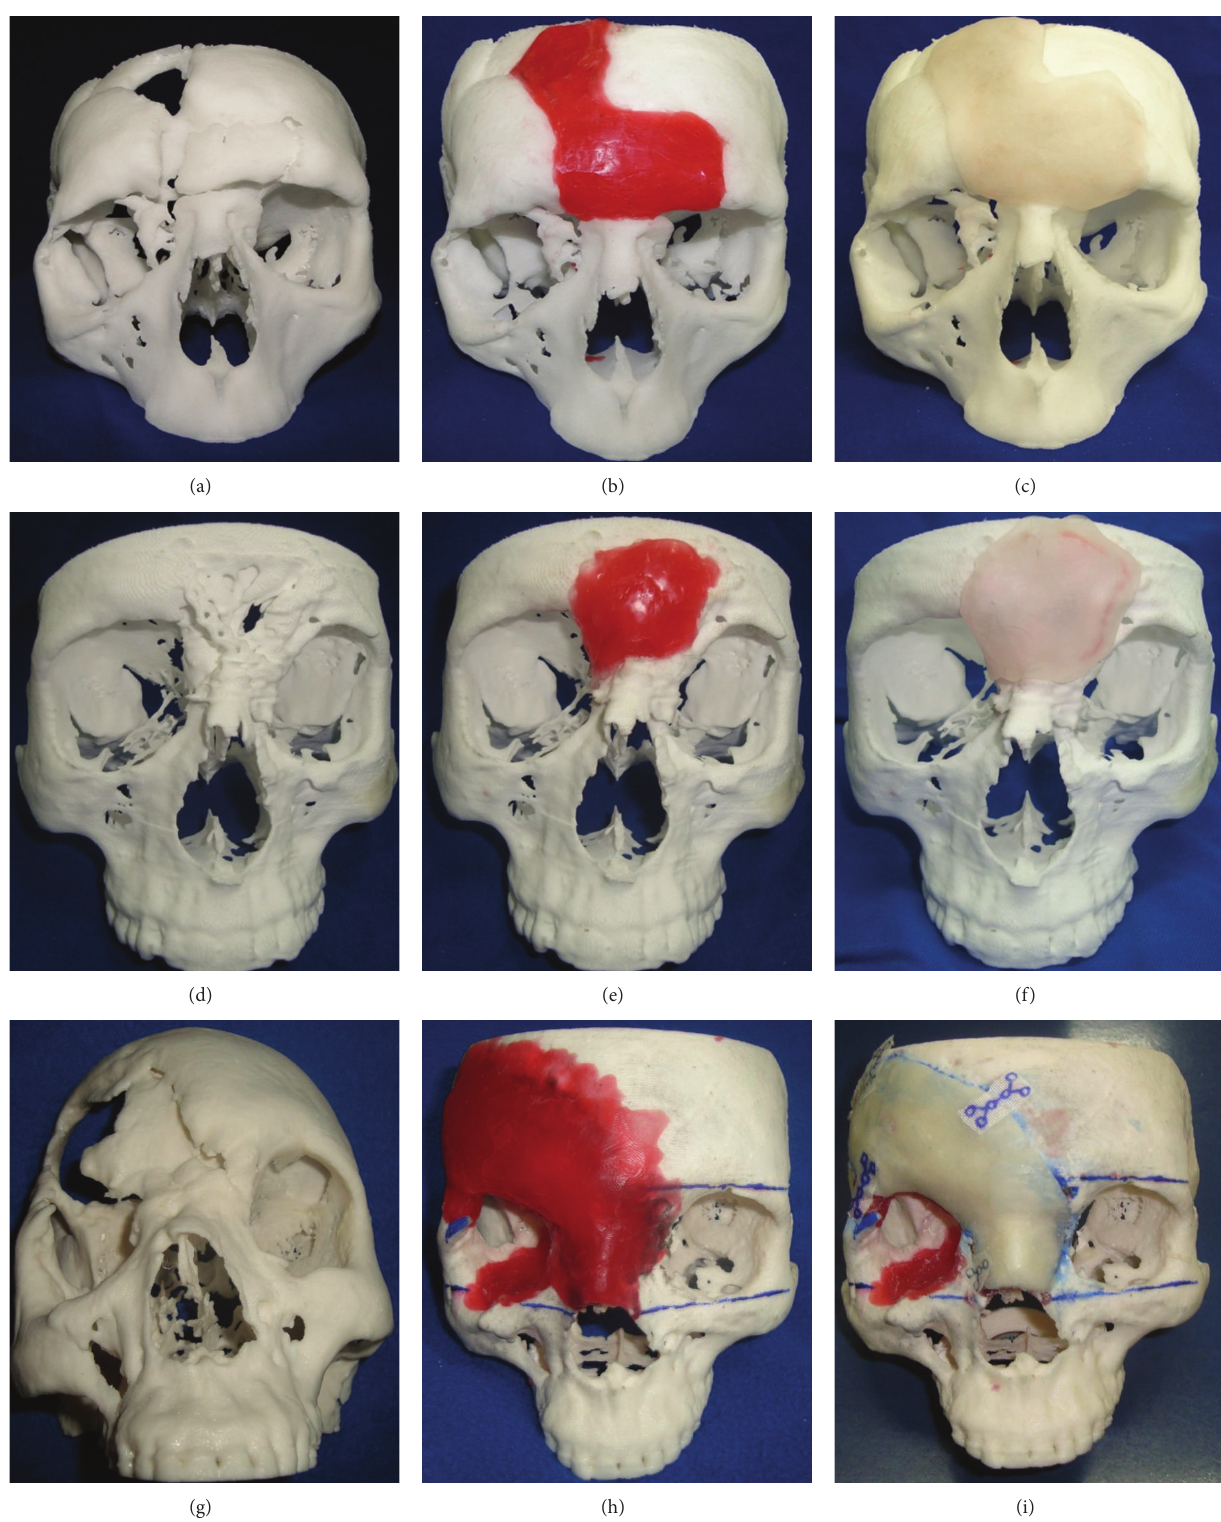
Figure 3: Preoperative customization of PMMA implants: initial aspect of the defect, wax covering the defects with a thickness-reduced wax, and PMMA reconstruction of the defect according to the desired anatomical contour (Case 1 ((a)–(c)), Case 2 ((d)–(f)), and Case 3